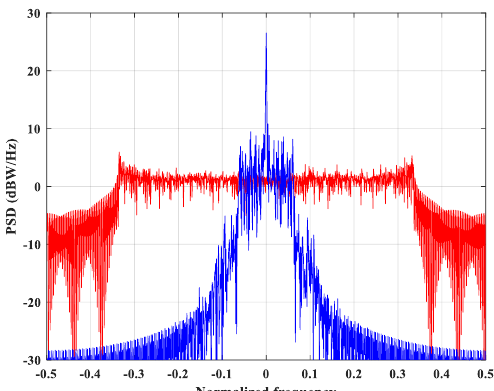
Figure 7. PSD for PM-OFDM-CDMA compared to OFDM-CDMA (2πh=0.6).